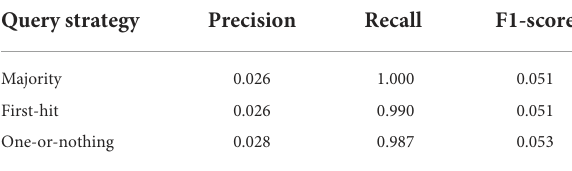
TABLE 2 Effect of different number of querying strategies.